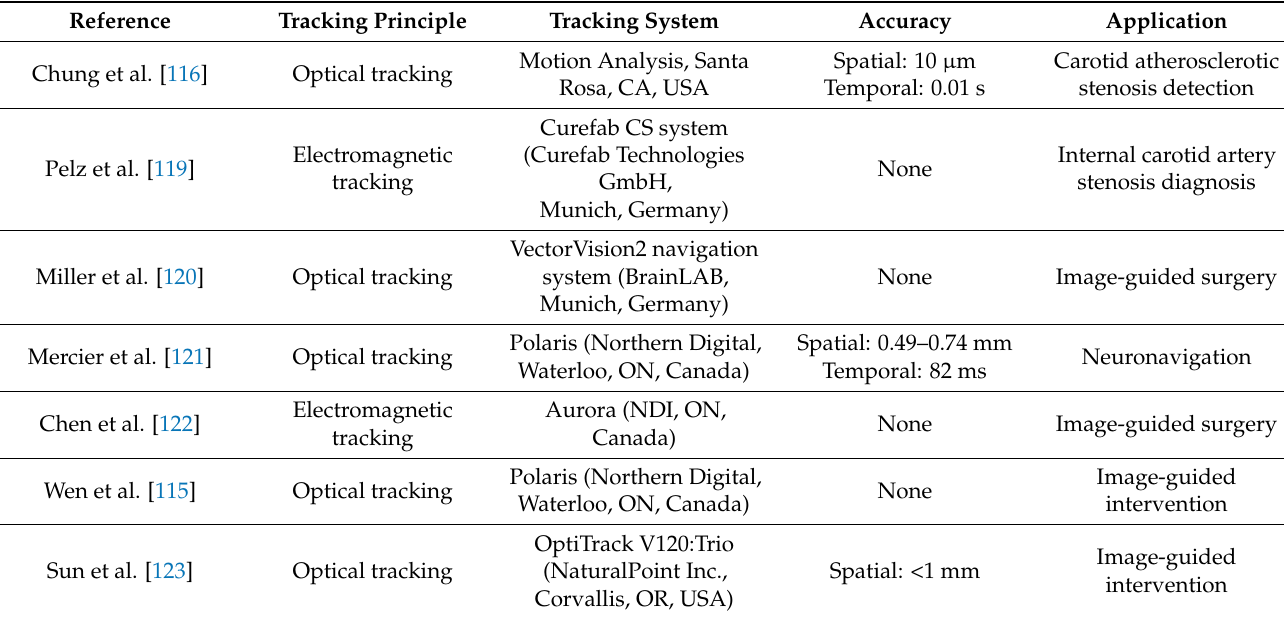
Figure 8. ( a ) A freehand 3D US imaging system with optical motion tracking system settings. Reprinted from [116] with permission. ( b ) The setup of a freehand 3D US imaging system with electromagnetic tracking. Reprinted from [122] with permission. ( c ) A low-cost 3D US image acquisition method. Reprinted from [126] with permission. Table 4. A summary of freehand 3D US imaging